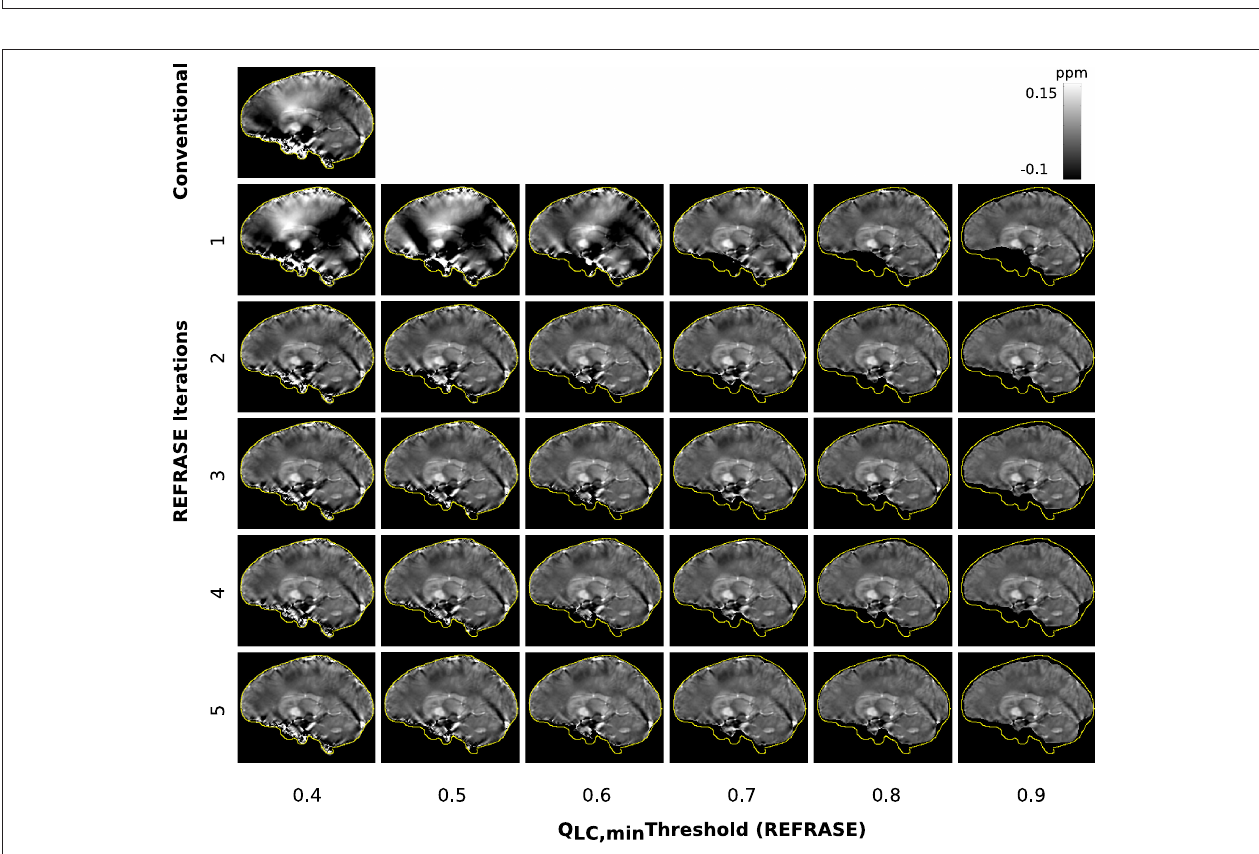
FIGURE 9 | Overview of the susceptibility maps obtained from the measured data, showing one sagittal sample slice per iteration (vertical) and per threshold configuration (horizontal). The top left image shows conventional reconstruction without REFRASE. Black background indicates the mask support of each illustrated image, while the yellow line indicates m max